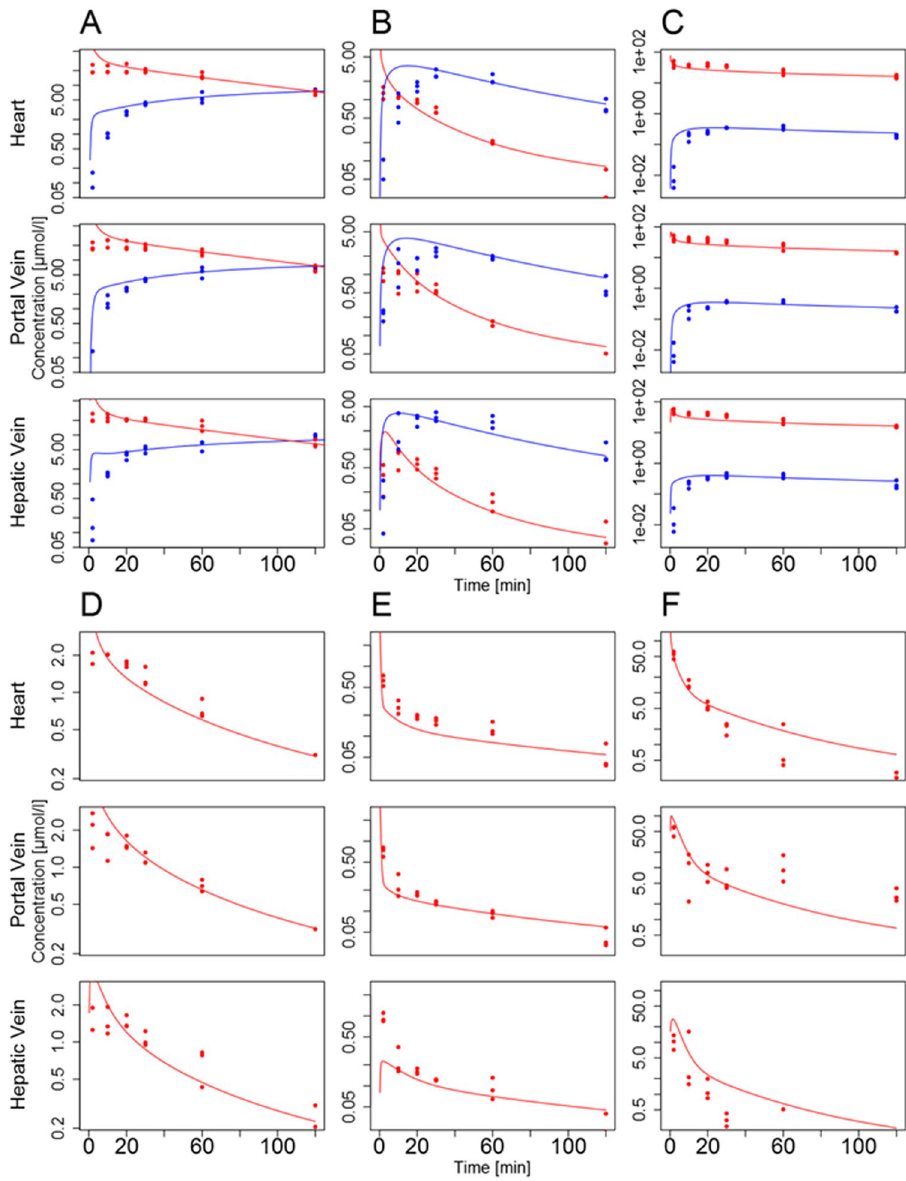
( A ), midazolam and 1 ′ -hydroxymidazolam ( B ), torsemide and hydroxytorsemide ( C ), codeine ( D ), talinolol ( E ), pravastatin ( F